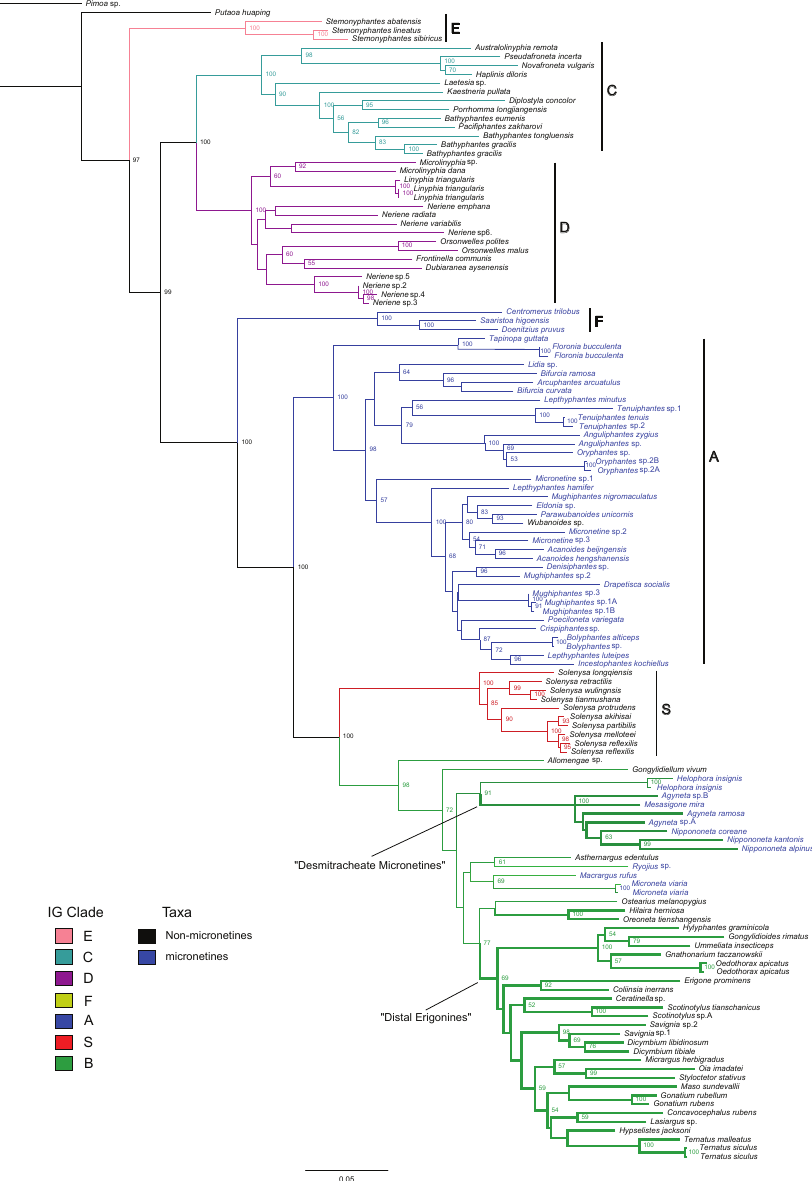
Figure 1. Linyphiid phylogeny resulting from the Maximum Likelihood analysis based on DNA se- quence data. Numbers at nodes indicate bootstrap support above 50%. Branches in color represent seven robustly supported main clades within Linyphiidae. Branches in bold indicate the desmitracheate type. Taxa in blue are currently placed in